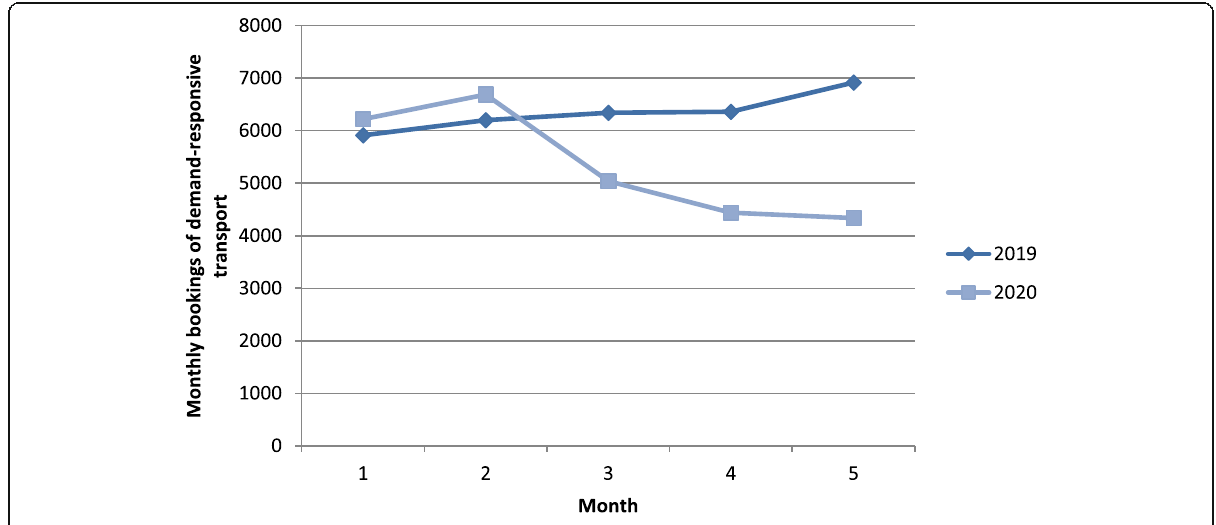
Fig. 1 Comparison of bookings of demand-responsive transport in the first months of the years 2019 and